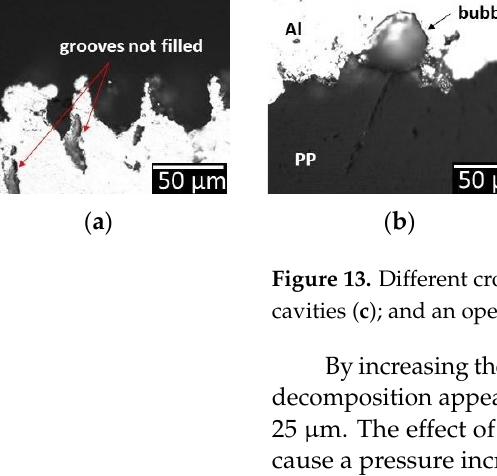
( c ) Figure 14. Cross-section of the weld area in transversal direction ( a ); and longitudinal direction ( b ); at the modulated power of 280 W; cross-section of the weld area in transversal direction at the mod- ulated power of 310 W ( c ). 3.3.3. Tensile-Shear Test Figure 15 shows the result of the tensile-shear test for laser-joined samples with dif- ferent modulated powers. It should be noted that the results of the tests are reported in max shear load; therefore, by increasing the power, the joints show higher loads due to the increase in the joint area until a certain point where the extensive degradation of the materials shows a negative effect that cannot be compensated for by increasing the joint area anymore. Therefore, in the case of small, separated bubbles, which were reported for 290 and 300 W modulated power, the shear load of the joints was not significantly affected, and an increasing trend was observed as a result of increasing the joint area. However, by the escalation of PP thermal decomposition in the form of bulges or through holes (310 W and above), the shear load of the joint decreased. Such a trend was also observed in the case of Al-to-polyamide laser joining [15]. More evaluations on the presence of small bub- bles need to be performed in order to identify their effect on the performance of the joints. In general, the max shear strength achieved between Al and PP is approximately 20 MPa. Table 6 presents different types of failure during the tensile-shear tests.